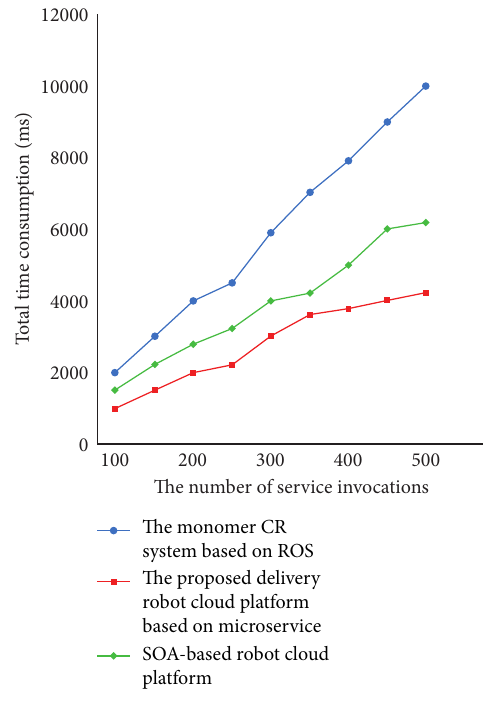
Figure 8: Comparison of the time consumption of the three